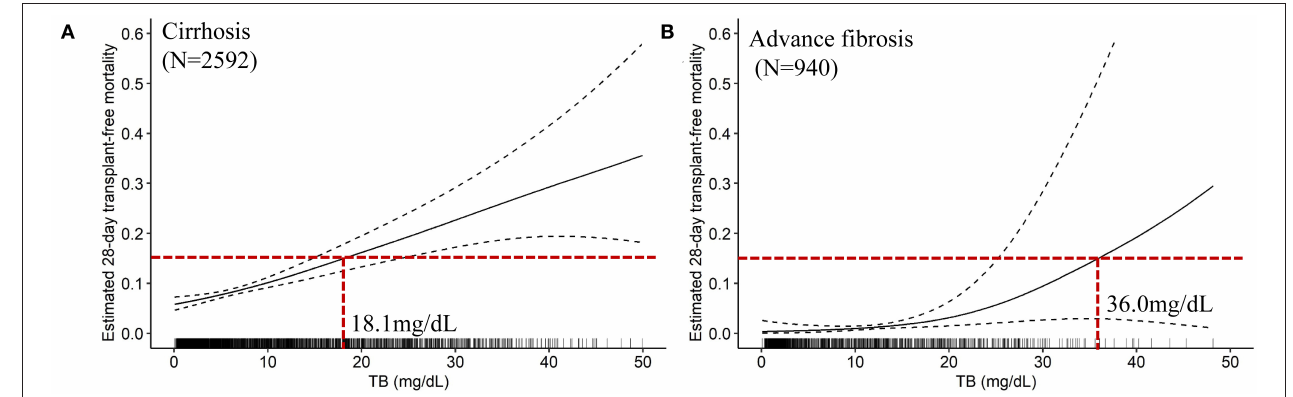
FIGURE 4 | The TB-mortality (28-day) correlation curves and the clinical cutoffs of cirrhosis and advanced fibrosis. (A) the TB-mortality correlation curve (28-day) of cirrhosis; (B) the TB-mortality correlation curve (28-day) of advanced fibrosis. TB, total bilirubin.